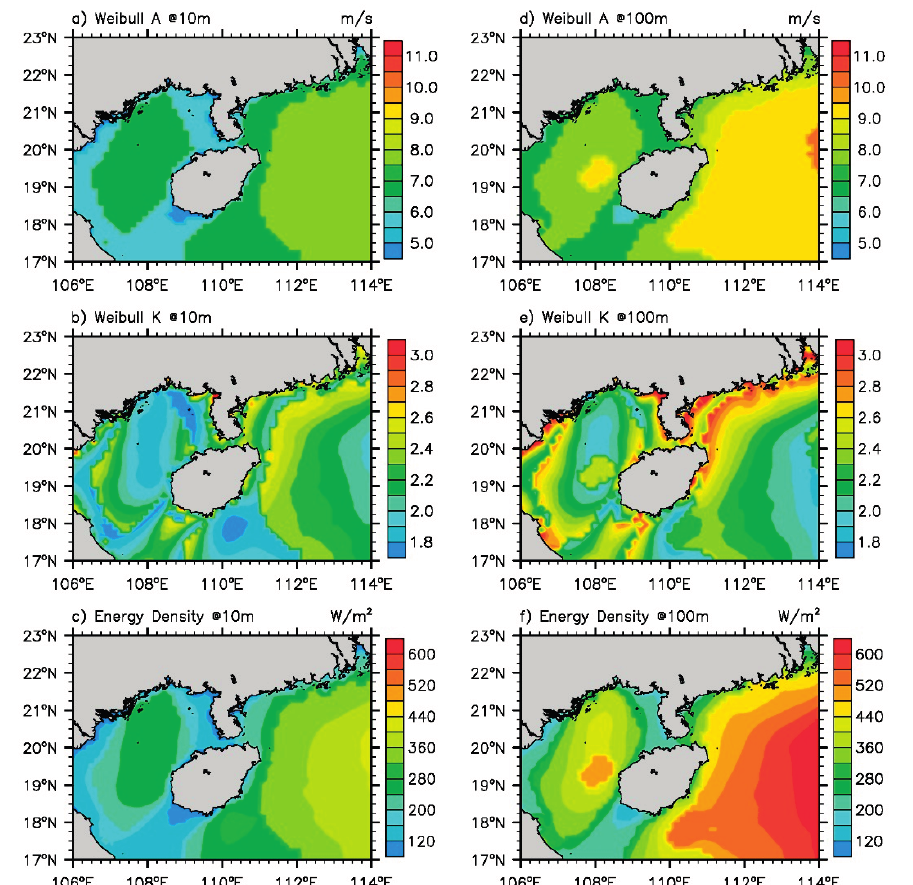
Figure 10. Wind resource statistics based on 8760 reconstructed winds at 10 m ( left ) and 100 m ( right ) covering SCS. Panels top: ( a ) Weibull A (m/s); ( b ) Weibull k; ( c ) wind power density (W/m 2 ), ( d ) Weibull A (m/s); ( e ) Weibull k; and ( f ) wind power density (W/m 2